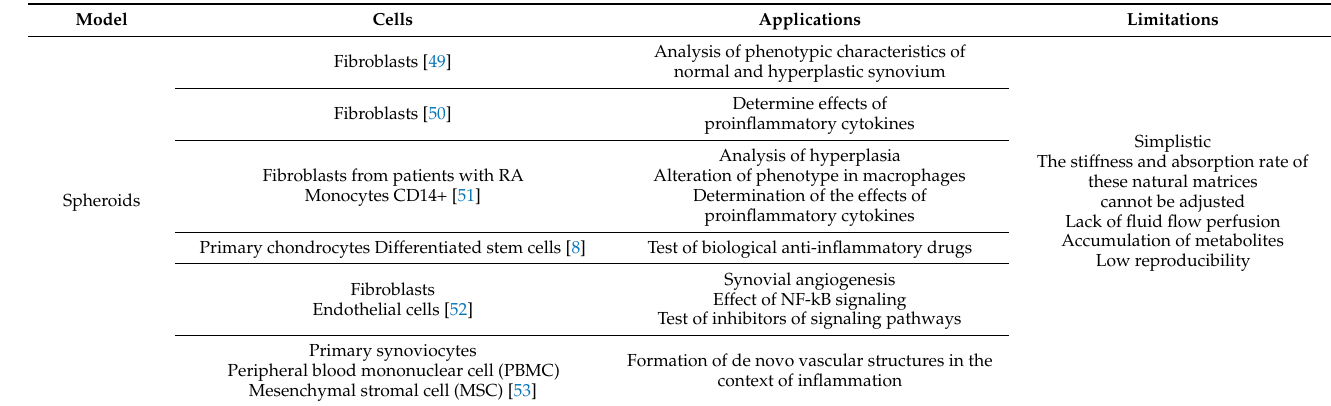
Figure 3. Different three-dimensional cell culture approaches can describe certain aspects of RA and even integrate themes to figure out how RA pathology affects other organs in the short and long term. Table 2. Selected three-dimensional models for rheumatoid